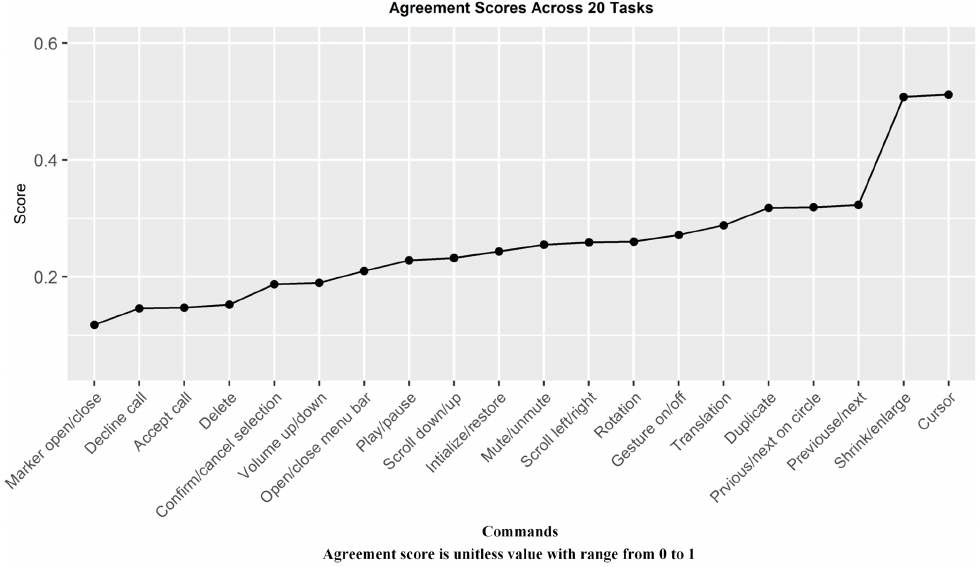
Figure 7. The agreement scores for the 20 commands when calculated based on the most preferred microgesture assigned to a